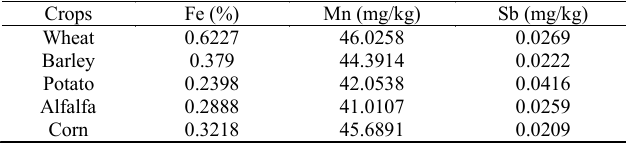
Table 5: Mean concentration heavy metals in the crops of Hamedan region